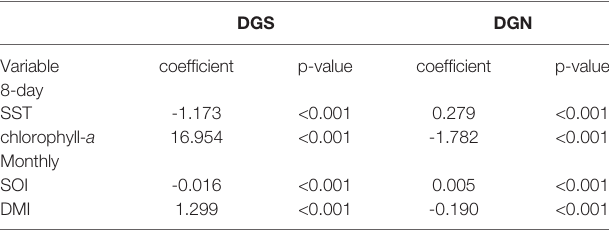
TABLE 2 | GLM model coef fi cients for the south-eastern (DGS) site and north- western (DGN) site. DGS DGN Variable coef fi cient